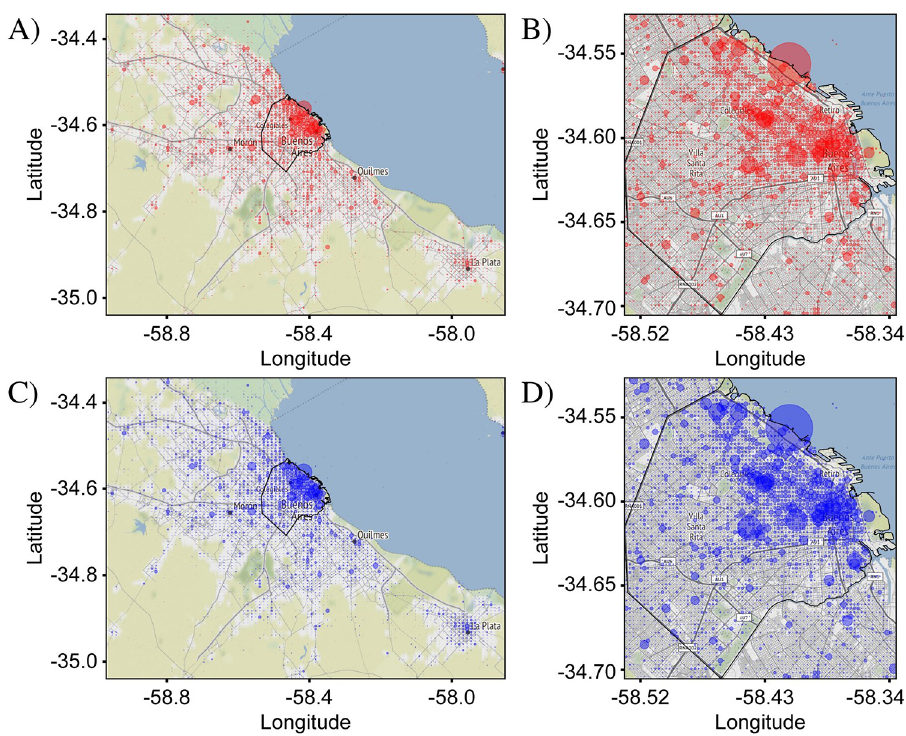
Fig 2. Comparison between distributions of tweets containing the letter ‘v’ and ‘b’ in CABA+ and CABA. Letter ‘v’ is represented in A and B by red circles. Letter ‘b’ is represented in C and D by blue circles, respectively. The size of each circle represents the number of tweets in the corresponding bin for each case. As ‘v’ and ‘b’ are orthographic elements, without independent meaning, no difference in their distributions is expected. In fact, the measured distributions are nearly identical to each other, with no visually noticeable differences. The distributions are also nearly identical to the distribution in Fig 1 showing all Spanish tweets, indicating that the dominant pattern is associated with the population density: The highest density of tweets is in the downtown area, while significantly lower densities are in the surrounding areas. Both points illustrate the need for a representation that highlights small differences in the distributions to enable a sensitive analysis. The total number of ‘v’ and ‘b’ tweets were 325,514 and 394,175, respectively. Base map and data from OpenStreetMap and OpenStreetMap Foundation under the Open Database